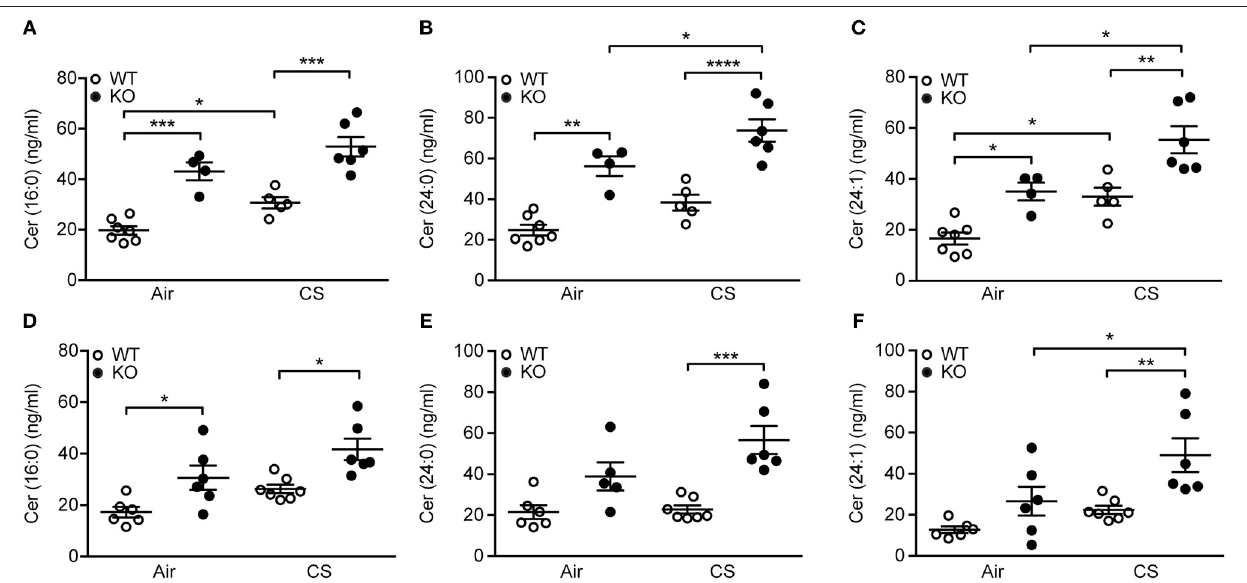
FIGURE 6 | Upregulation of pulmonary ceramides in cigarette smoke (CS)-exposed SP-D-deficient mice. SP-D-deficient mice show higher levels of long-chain and very long-chain ceramides in bronchoalveolar lavage fluid (BAL) after (A–C) 12 weeks and (D–F) 3 days of CS exposure compared to WT littermates. n = 4–7. * p <